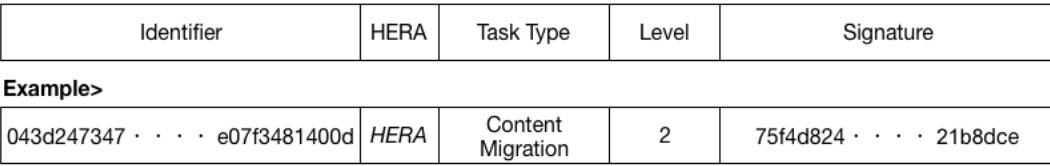
Figure 5. HER Acknowledgement message format and